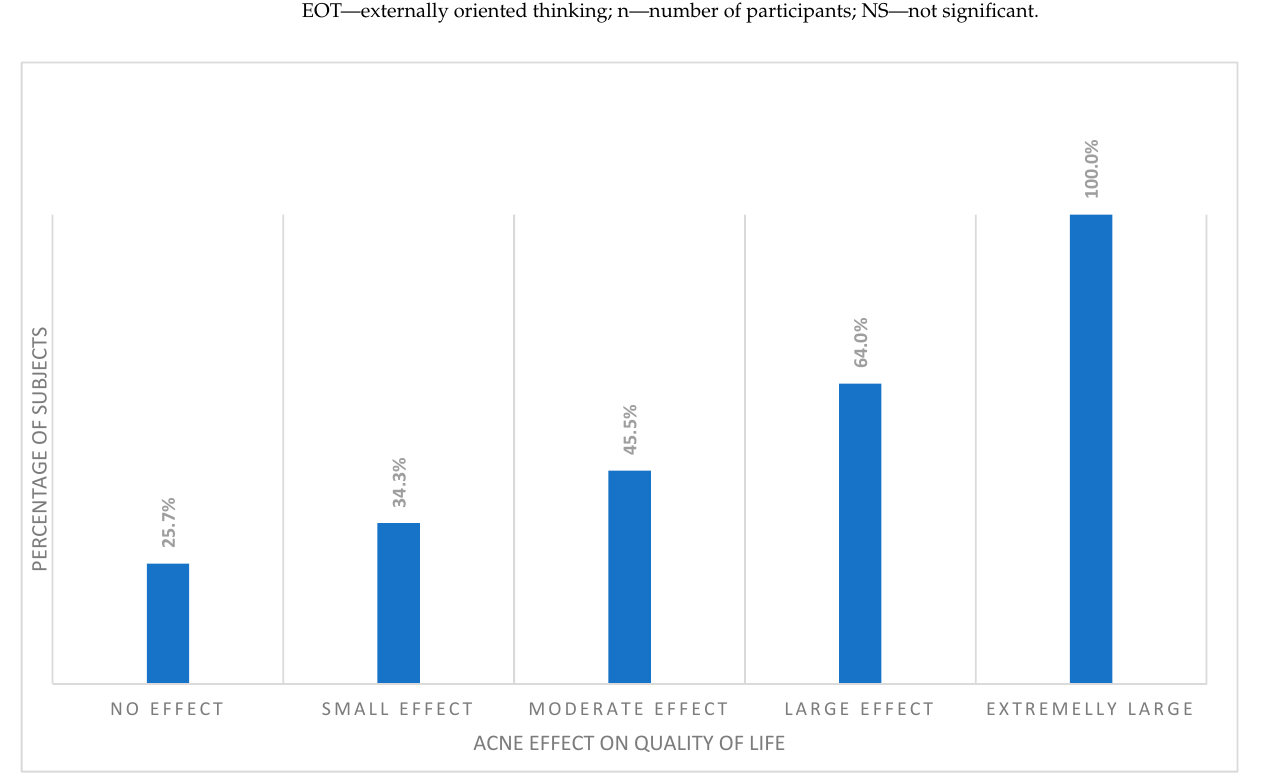
Table 2. Alexithymia in pupils with and without acne.